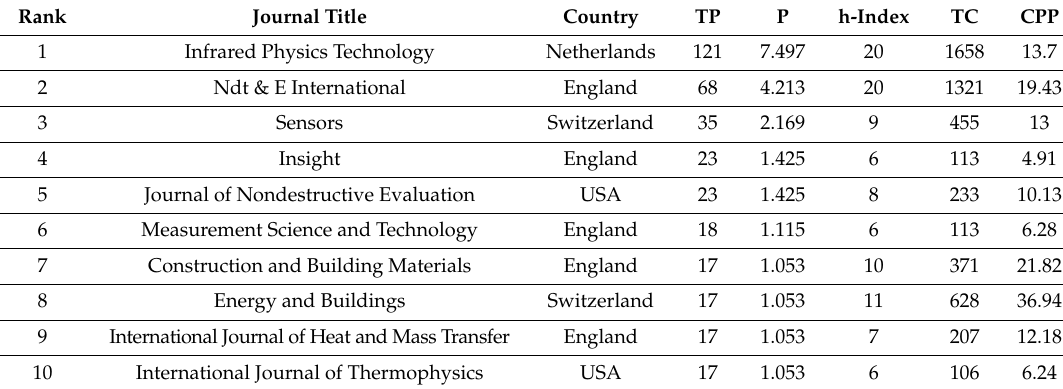
Table 3. Distribution of the top 10